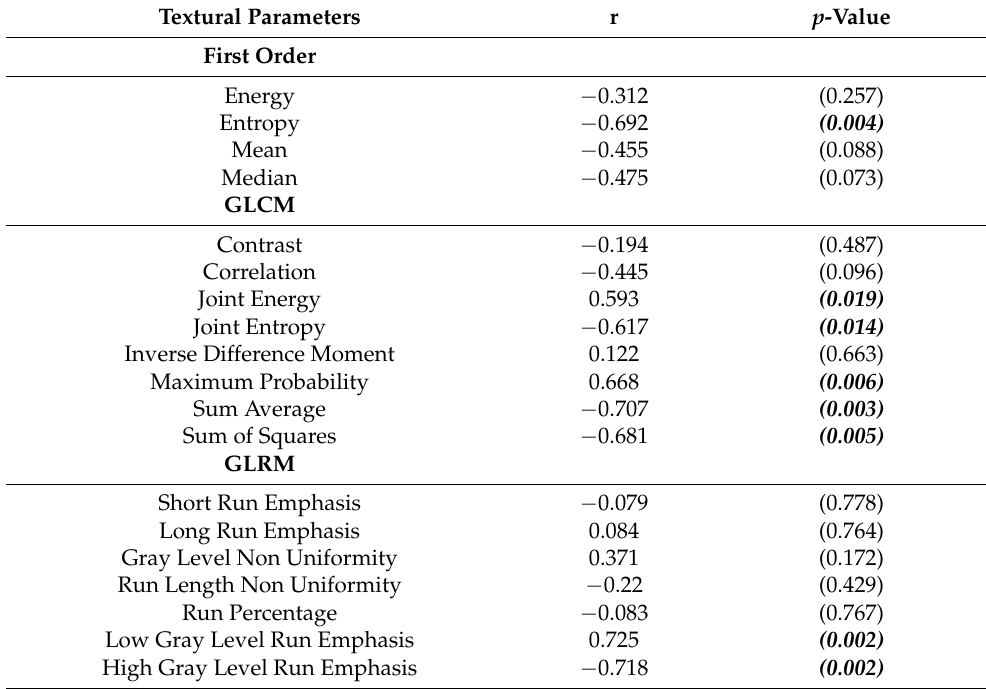
Table 4. Correlation between textural parameters and failure stress in great trochanter MRI. In bold and italic, p -value under 0.05. (GLCM: grey level co-occurencematrix; GLRM: grey level run- length matrix).